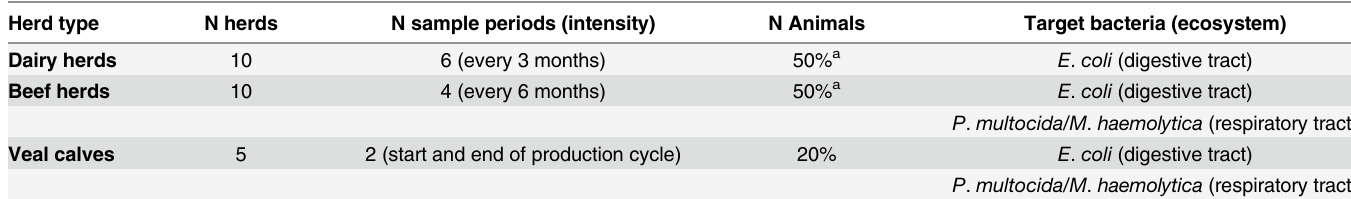
Table 1. Overview of the study design with respect to sampling scheme to monitor antimicrobial resistance in target bacteria. Herd type